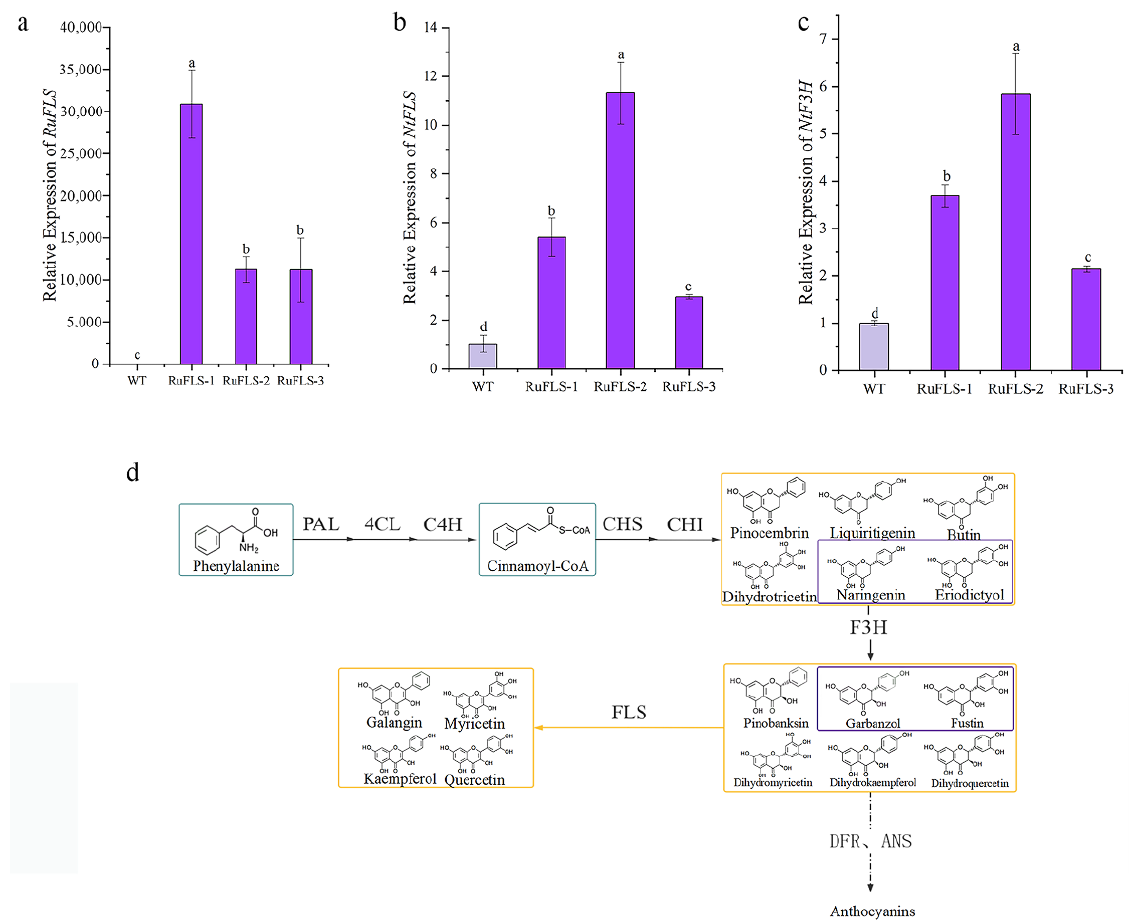
Figure 5. Expression patterns of flavonoid biosynthesis pathway genes in WT and RuFLS2-overexpressing tobacco. ( a ) RuFLS2 gene; ( b ) NtFLS gene; and ( c ) NtF3H gene. Significant differences between means ( p < 0.05) are indicated by lowercase letters (a, b, c and d) above the bars. ( d ) Biosyn- thetic pathway of flavonoid compounds in blackberry. WT represents wild-type tobacco ( Nicotiana tabacum cv. Wisconsin 38). RuFLS2-1, RuFLS2-2 and RuFLS2-3 represent three different transgenic tobacco lines.